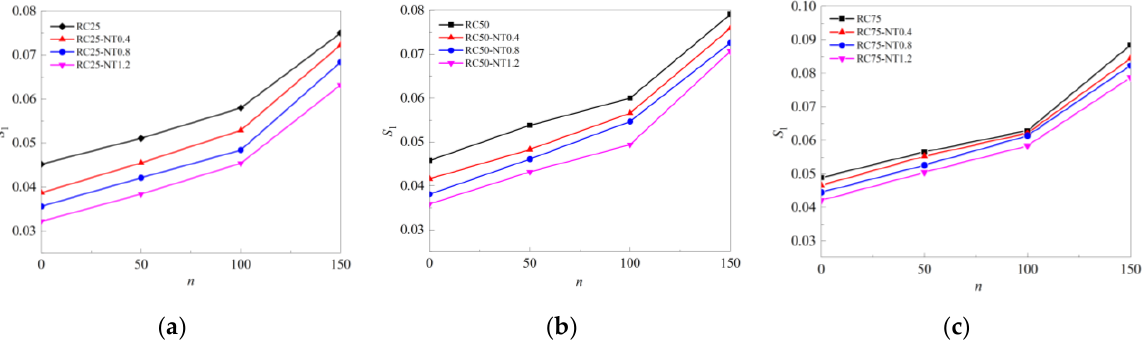
Figure 6. The variation curve of initial water absorption S 1 with freezing – thawing cycle n . ( a ) R25 group; ( b ) R50 group; ( c ) R75 group.